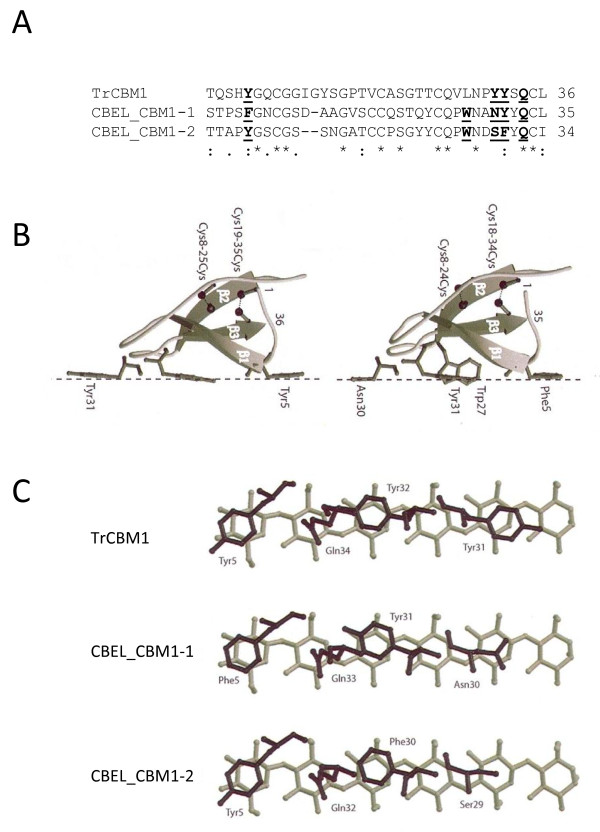
Modeling of the CBM1s from the CBEL protein.A) Multiple sequence alignment of CBEL_CBM1-1, CBEL_CBM1-2 with the CBM1 of cellobiohydrolase I from Trichoderma reesei (TrCBM1, Uniprot/KB accession number: P62694). Amino residues putatively important for binding to crystalline cellulose are in bold and underlined. B) Comparison of the lateral faces of the ribbon diagrams of TrCBM1 (left) and CBEL_CBM1-1 (right). The strands of the β-sheet are numbered β1, β2 and β3 from the N- to the C-terminus. The aromatic residues involved in the binding to cellulose are displayed in grey ball-and-sticks. The Asn (replaced by Ser in CBEL_CBM1-2) and Trp residues susceptible to interact with cellulose are similarly displayed in grey ball-and-sticks. The four Cys residues linked to disulphide bonds (dashed lines) are displayed in black ball-and-sticks and numbered. C). Precise view of the binding model of CBM1s from TrCBM1 and CBEL. Only the aromatic residues (Phe and Tyr) stacking on the pyranose ring of the glucose units and close hydrophilic residues (Gln, Asn and Ser) susceptible to create hydrogen bonds with the hydroxyls of the glucose units, are displayed in black ball-and-sticks. Only six β1,4-linked glucose units are drawn in grey ball-and-sticks. Cartoons are drawn with Molscript
[67], and rendered with Raster3D
[68]